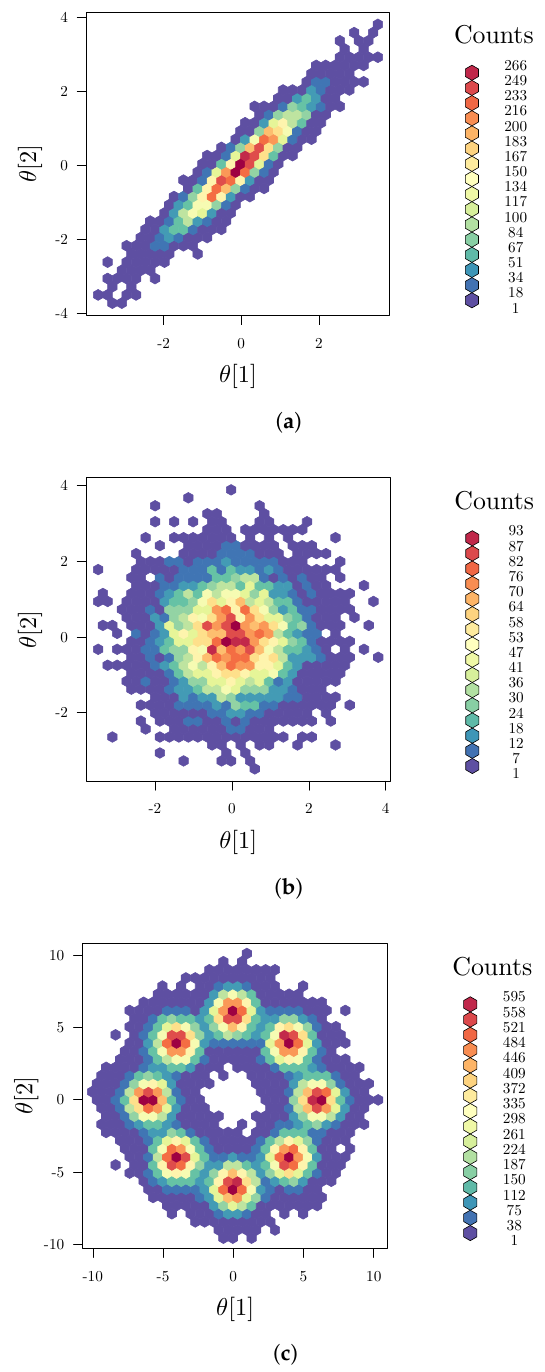
Figure 3. Illustrative example of parameter dependencies: ( a ) linear correlation with Corr [ 1,2 ] = 0.95; ( b ) no correlation with Corr [ 1,2 ] = 0; and ( c ) nonlinear correlation but zero linear correlation ( Corr [ 1,2 ] = 0); here, eight standard Gaussian distributions are superimposed in a circular structure and properly rescaled providing a multi-modal density function. ( a ) linear correlated parameters; ( b ) linear uncorrelated parameters; ( c ) nonlinear